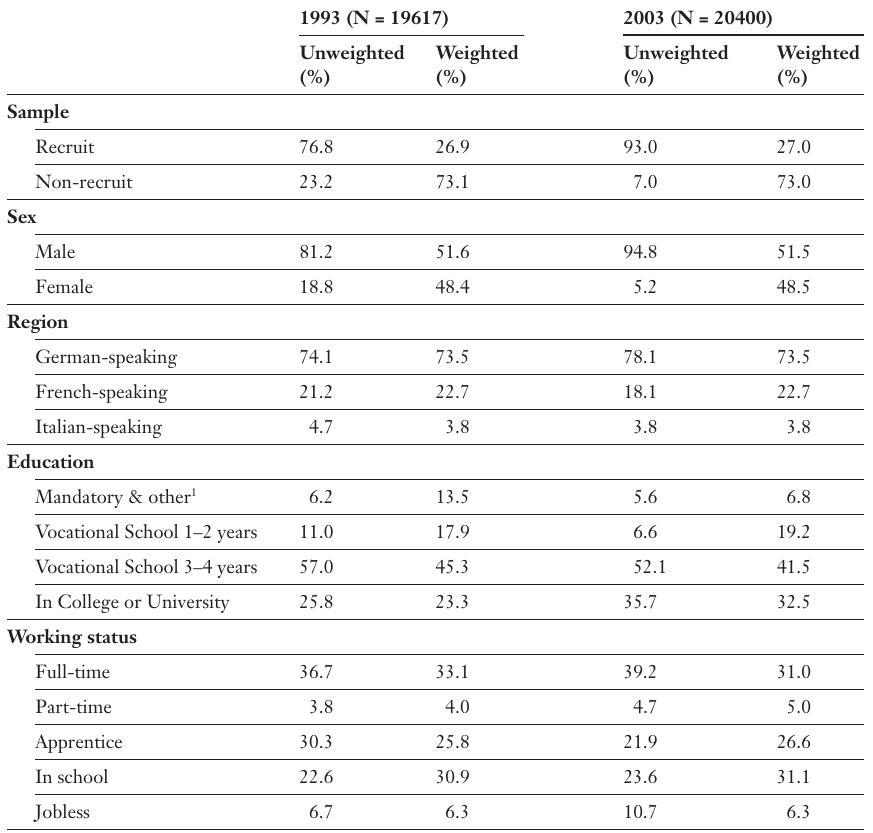
Table 1 Demographic charac- teristics of the study participants in the 1993 and 2003